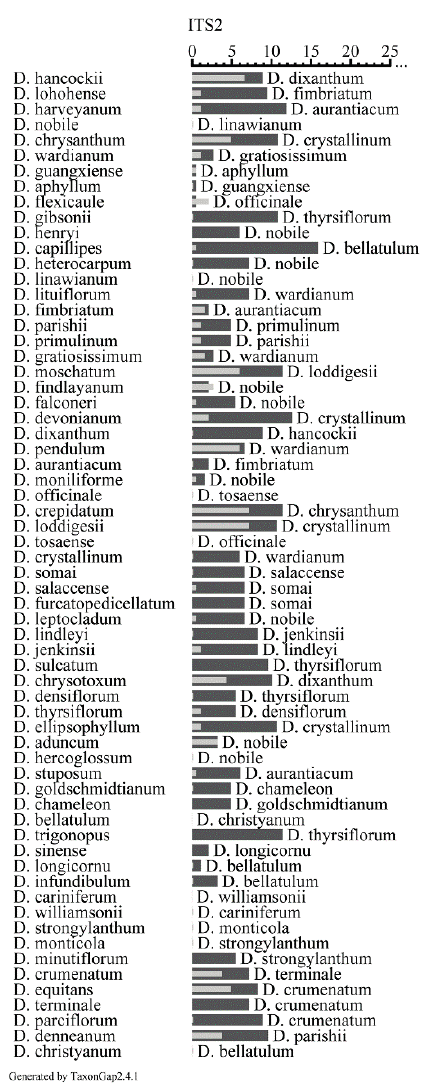
Figure 2. The heterogeneity and separability for individual taxa of ITS2 based on 64 Dendrobium species by TaxonGap. The left side shows the complete list of Dendrobium species used in this study, including sequences we generated and those retrieved from GenBank (see Table 3 and Table S1). The right side depicts the within species heterogeneity (presented as light gray horizontal bar) and between-species separability (presented as dark grey horizontal bar) values (calculated by using similarity matrix for biomarker ITS2) with different OTUs (Operational Taxonomic Units) as matrix rows for ITS2. The names of the closest relatives (the taxon with the smallest separability) are listed at the right side of the dark grey